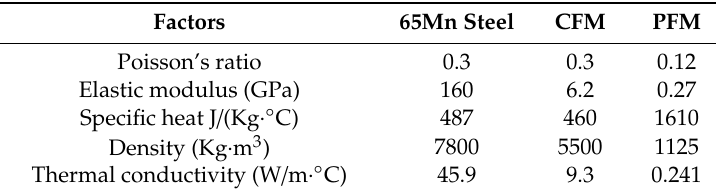
Table 2. Thermophysical properties of the pin and disc.